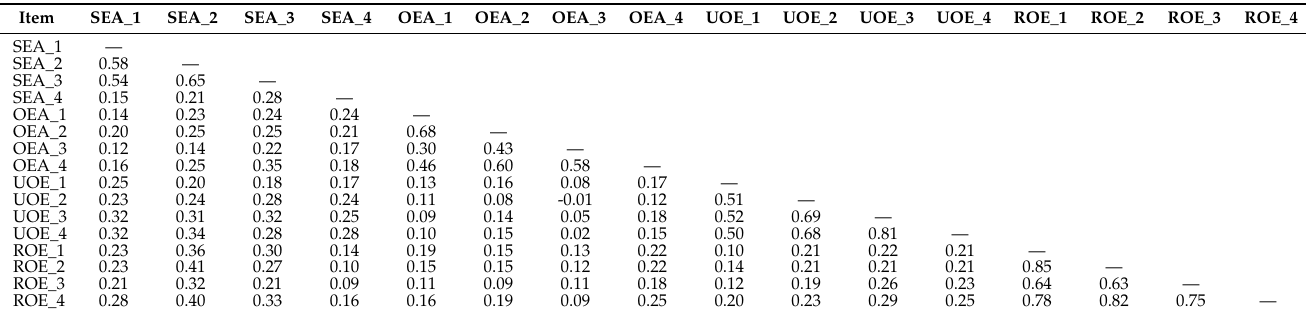
Table 5. Inter-item polychoric correlation